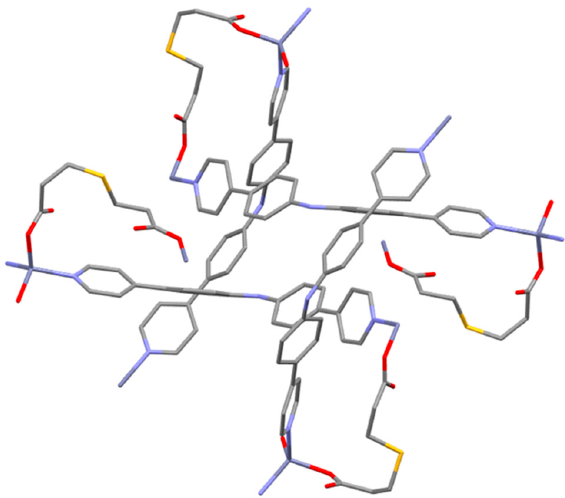
(between the centroids of the aromatic rings) and N-H ¨¨¨ O hydrogen bonds [61].